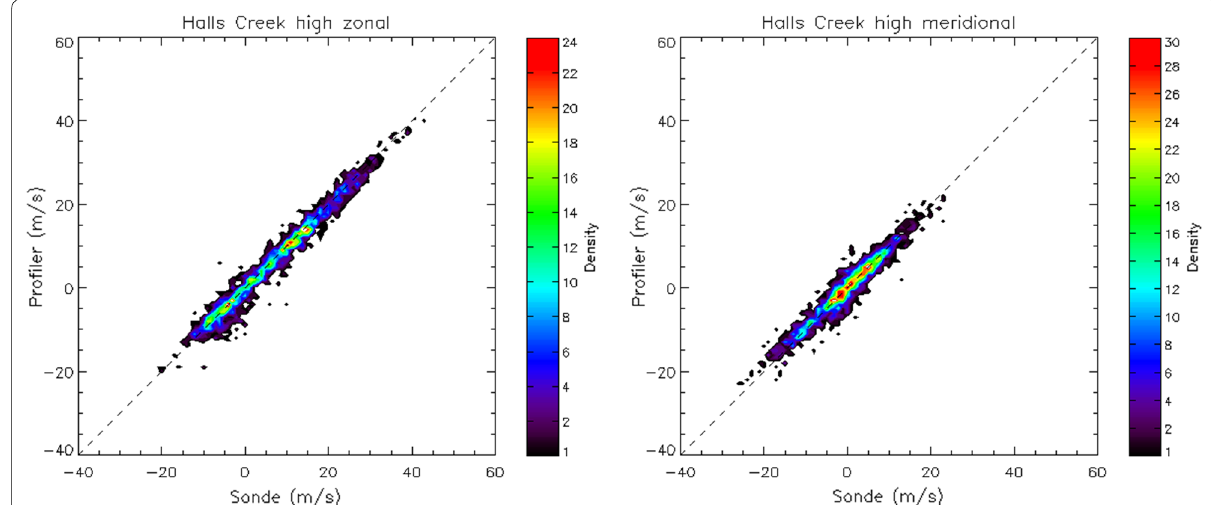
Fig. 4 Zonal (left) and meridional (right) colored contour wind comparisons from the Halls Creek profiler. The sonde data are shown on the x axis, with the profiler data on the y axis, and colors indicate data density